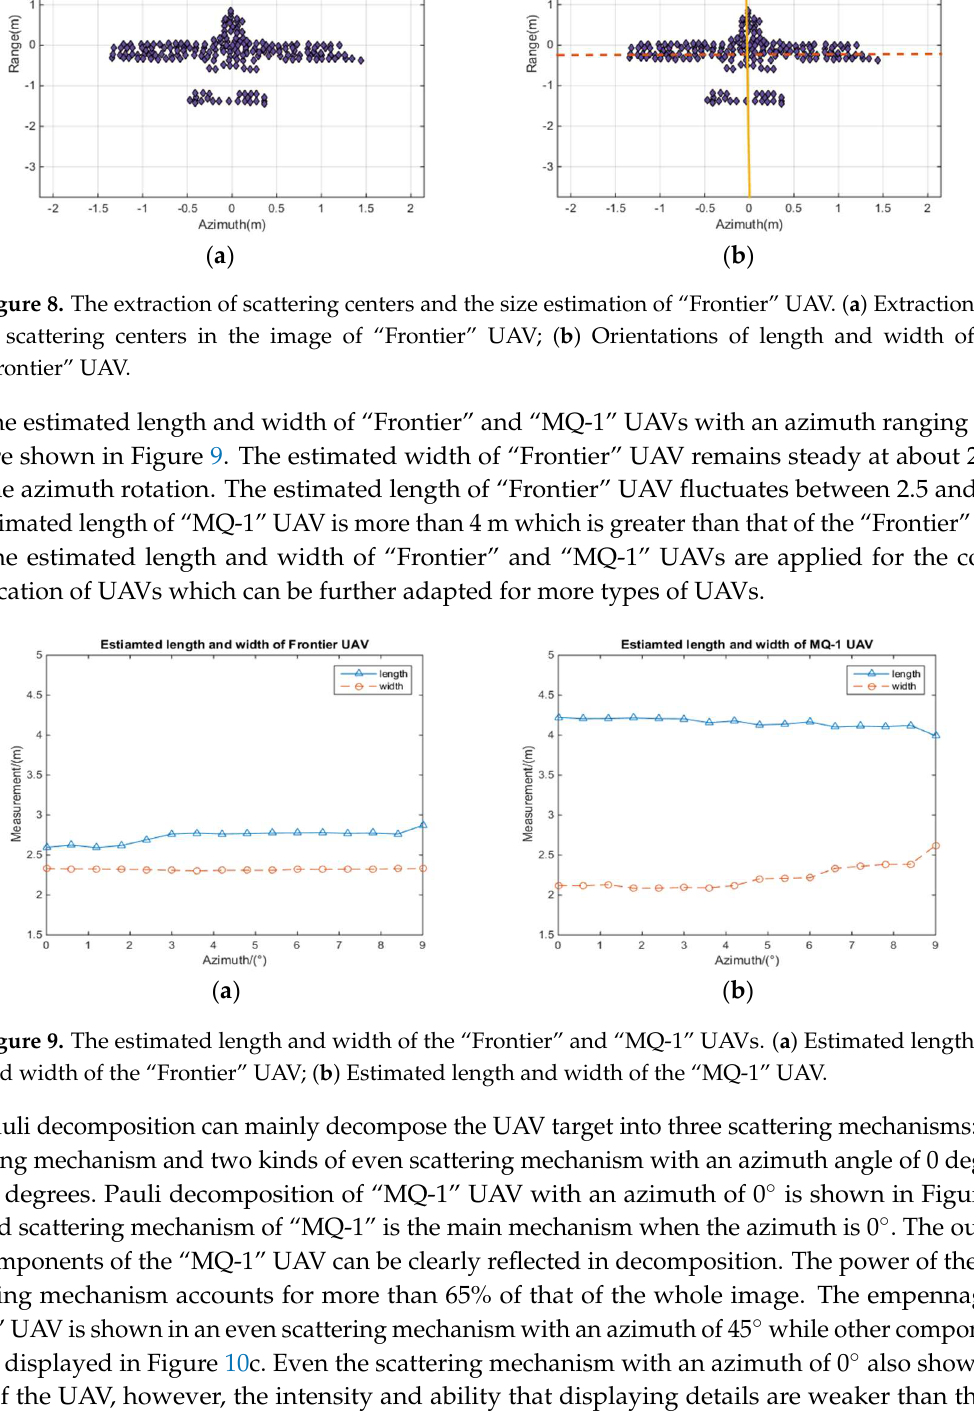
( d ) Figure 7. The empennage and missile parts of “MQ-1” UAV with FFT and CBP algorithm. ( a ) Empennage part of “MQ-1” in HH polarization by FFT; ( b ) Empennage part of “MQ-1” in HH polarization by CBP; ( c ) Missile parts of “MQ-1” in HH polarization by FFT; ( d ) Missile parts of “MQ- 1” in HH polarization by CBP. Firstly, the extraction of strong scattering points of the “Frontier” UAV is carried out which are chosen based on the magnitude of the imaging results and the application of the sliding window (20 by 20). Two hundred strong scattering points are filtered out from the image of the “Frontier” UAV that are utilized to estimate the length and width information. Additionally, these scattering points will be employed to inverse structural information with polarimetric decomposition methods. Principal Component Analysis (PCA) is an effective method for calculating target size in a two- dimensional Cartesian coordinate space and estimating the length and width of “Frontier” UAV with